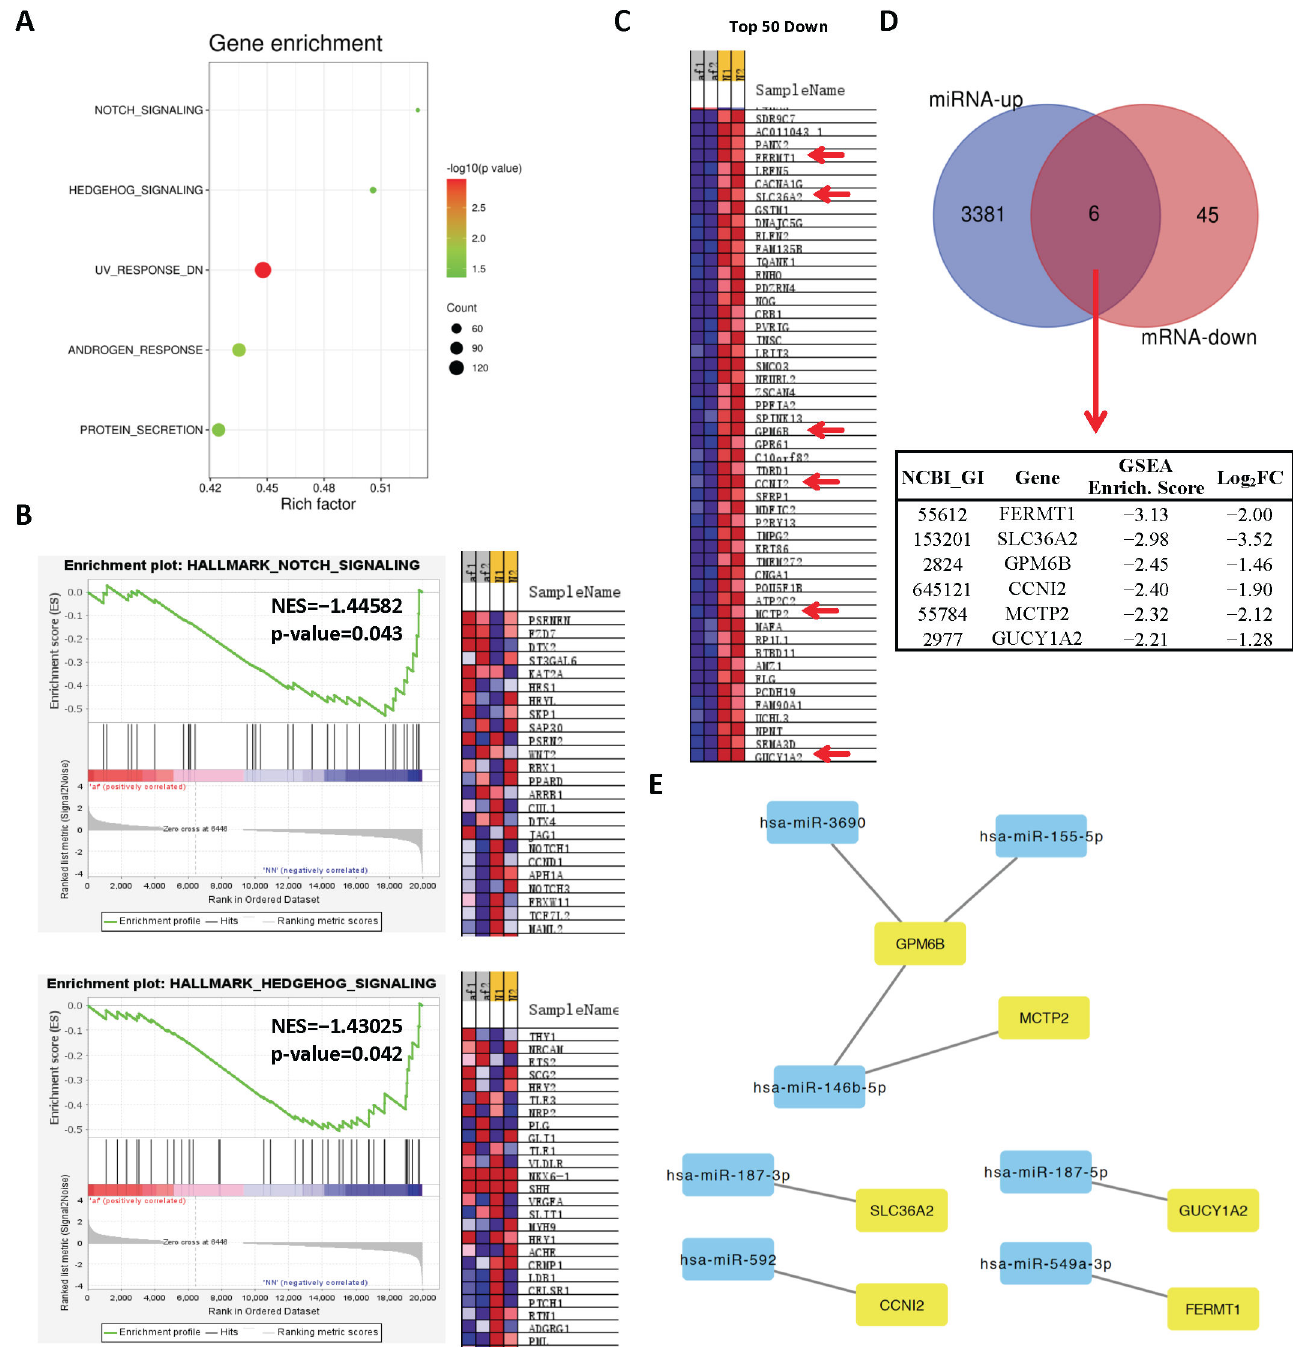
Figure 5. Analysis of downregulated genes and selection of candidate miR–mRNA pairs. ( A ) Gene- set enrichment analysis (GSEA) of downregulated genes. ( B ) Enrichment plots of some of the top enriched pathways. ( C ) Heat map showing top 50 negatively enriched genes in GSEA based on enrichment score. ( D ) Venn diagram showing overlapping genes between top 50 negatively enriched genes in GSEA (blue) and all predicted targets of top 9 upregulated miRs in the RNA-seq dataset (red). A total of six overlapping genes between groups were selected as potential candidates and their enrichment scores and log 2 (FoldChanges) are listed in the table. ( E ) Interaction network of negatively enriched genes in GSEA and their negatively correlated